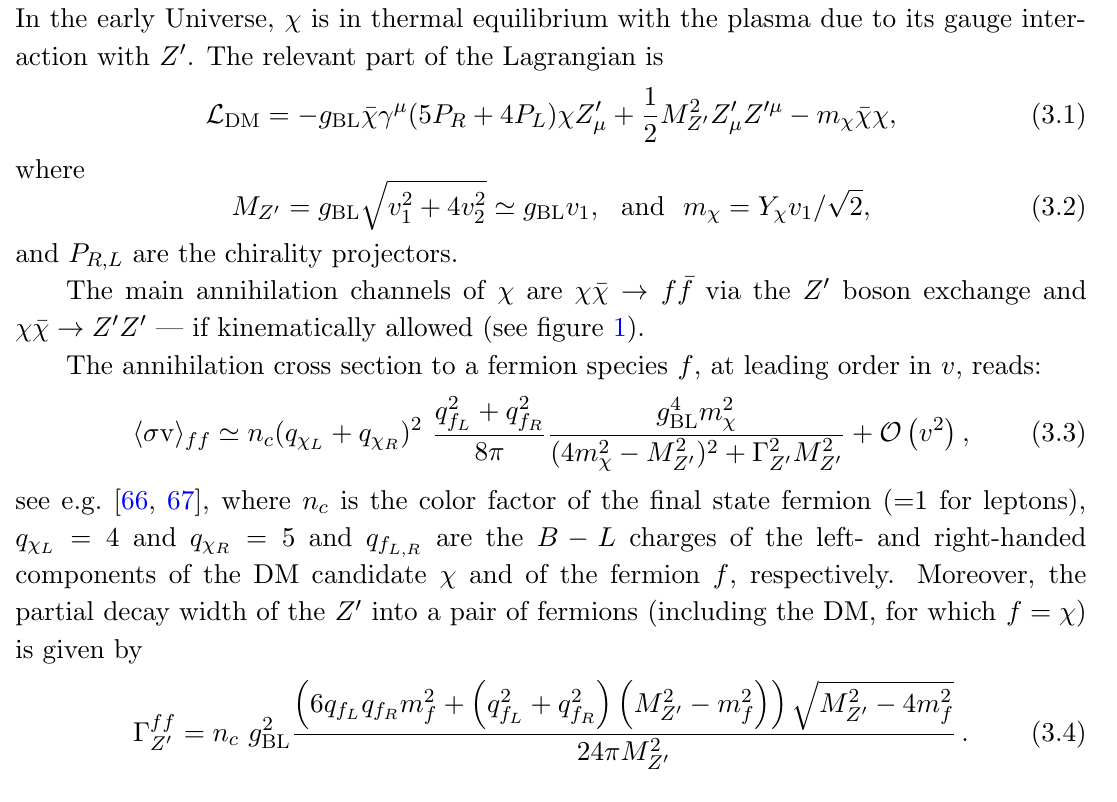
Figure 1 . DM annihilation channels (cid:31) (cid:22) (cid:31) channel opens up when M 2 diagram is typically